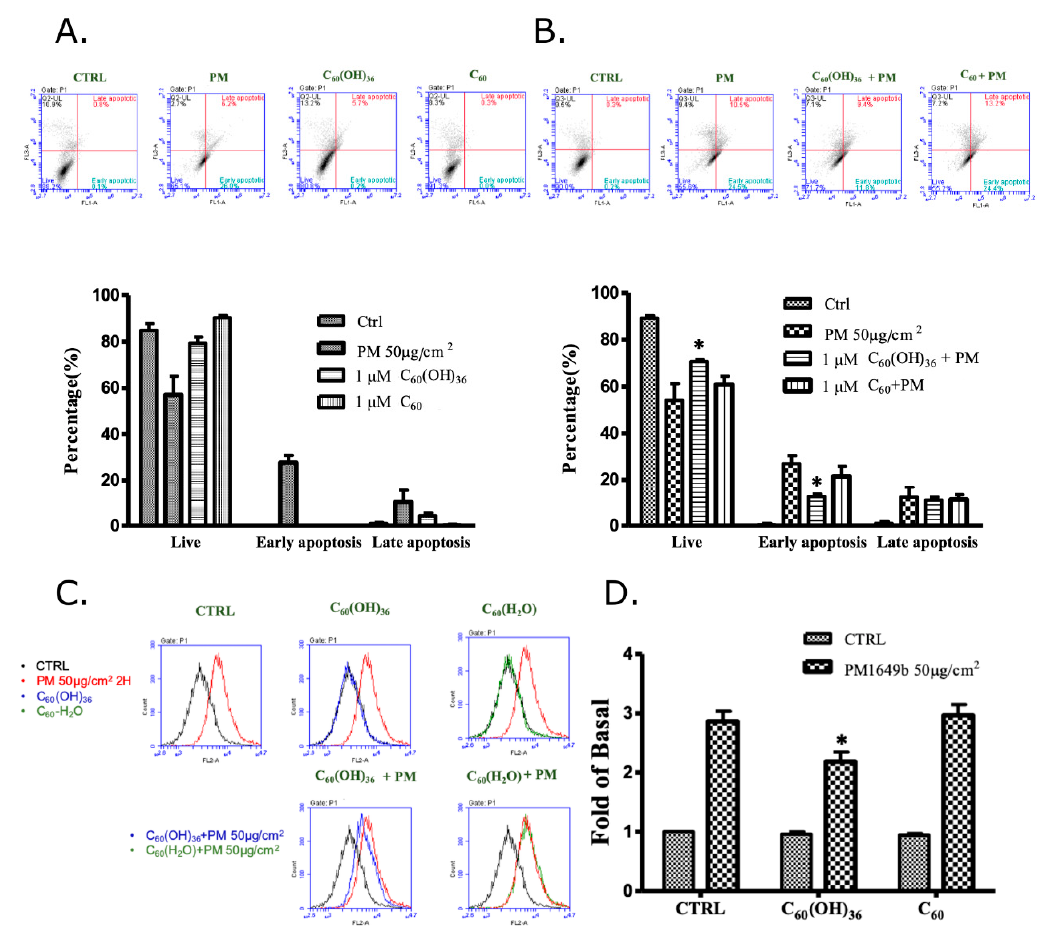
Figure 3. E ff ects of fullerenol (C 60 (OH) 36 ), fullerene (C 60 ), and PM on cell apoptosis in human skin keratinocyte (HaCaT) cells. Cells were treated with ( A ) fullerenol (C 60 (OH) 36 ), fullerene (C 60 ), or PM for 24 h, and pre-treated with ( B ) fullerenol (C 60 (OH) 36 ) and fullerene (C 60 ) (1 µ M) for 1 h; then, cells were treated with PM (50 µ g / cm 2 ) for another 24 h, and values were measured via flow cytometry by Annexin V-fluorescein isothiocyanate (FITC) / propidium iodide staining. ( C ) The raw data and ( D ) the calculated values of caspase-3 activity, which were measured by flow cytometry, were presented. The upper panel of ( A , B ) shows the raw flow cytometry data, and the lower right quadrant of each raw figure indicates the percentage of cells undergoing early apoptosis. The bar graphs illustrate the cumulative counts observed using the flow cytometer. All data are expressed as means ± SEM values from at least three individual experiments. * p < 0.05, as compared to the values for the PM exposure group.